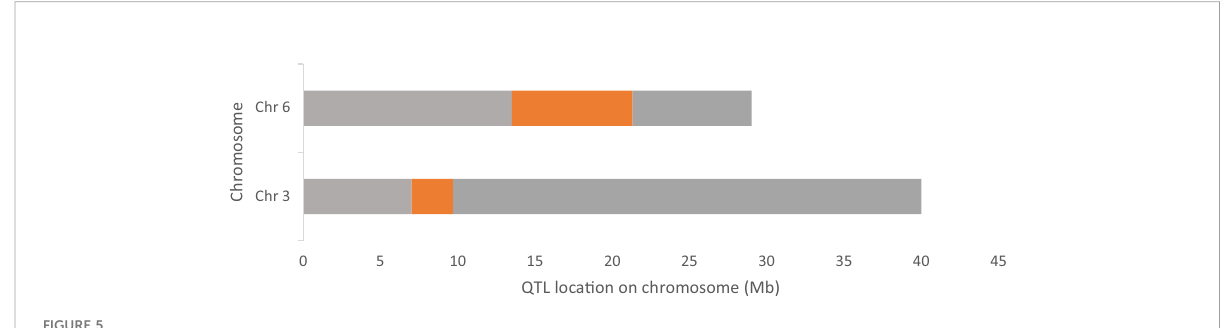
FIGURE 5 Chromosome 3 and 6 of cucumber showing the identi fi ed QTL region for parthenocarpy trait (in orange-coloured